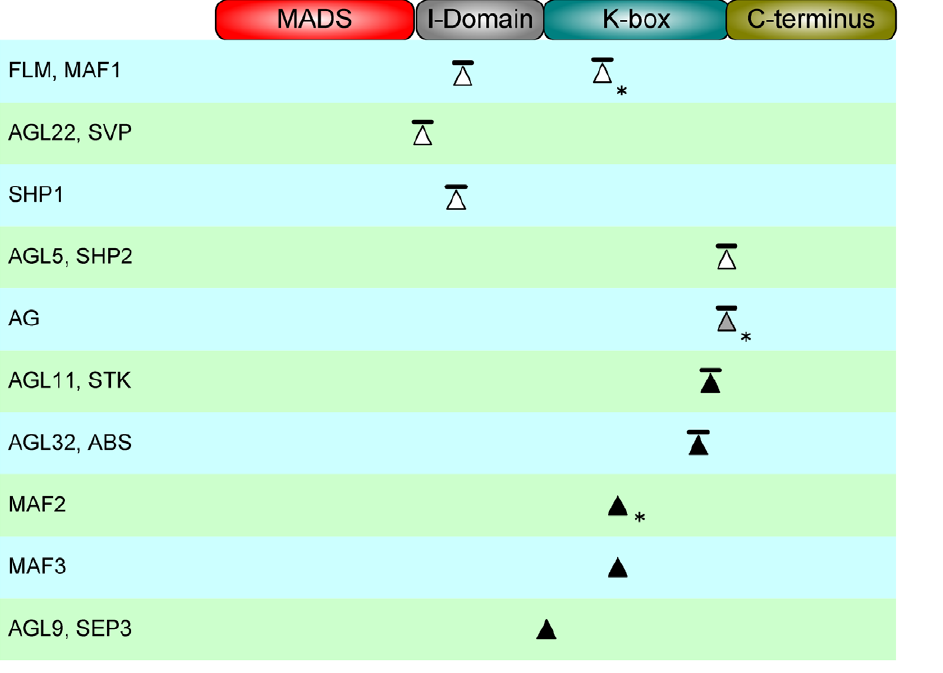
Figure 1. Putatively functional Alternative Splicing (AS) events in the Arabidopsis MIKC-type MADS-box family. Triangles indicate the position of AS events in relation to the protein-domain architecture of MIKC proteins. Bars on top of the triangles indicate that the event overlapped with at least one computationally predicted interaction motif. Asterisks indicate that the transcripts associated with the AS events are not annotated in TAIR 10. The color of a triangle indicates whether the AS induced polymorphism corresponding to the event was only identified in Arabidopsis (white), was conserved between different species but was not observed in Arabidopsis (grey) or, was conserved between Arabidopsis and other species (black).